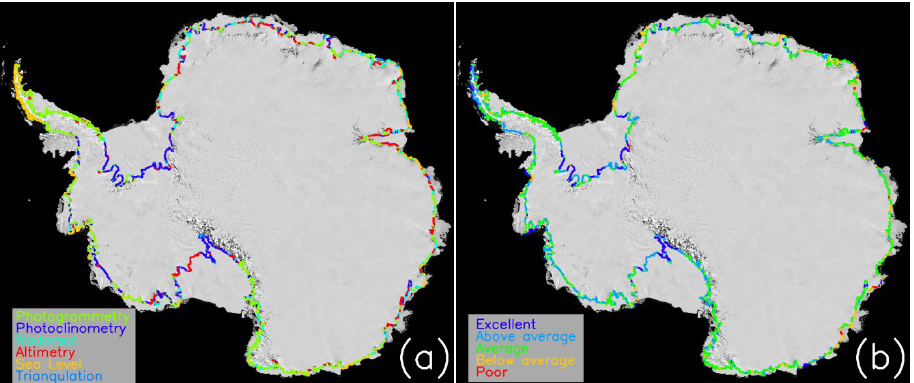
Figure 6. The ASAID grounded ice boundary. (a) Colored lines represent the DEM source of selected elevation values. The corresponding percent frequencies of occurrence are: photogrammetry (green, 33%); photoclinometry (dark blue, 26%); Radarsat (cyan, 17%); altimetry (red, 13%); sea level (orange, 9%); and triangulation (light blue, 2%). (b) Colored lines represent the confidence in the selected elevations. The corresponding percent frequencies of occurrence are: Excellent (dark blue, 18%); Above Average (cyan, 36%); Average (green, 40%); Below Average (orange, 5%); and Poor (red, 0.5%).